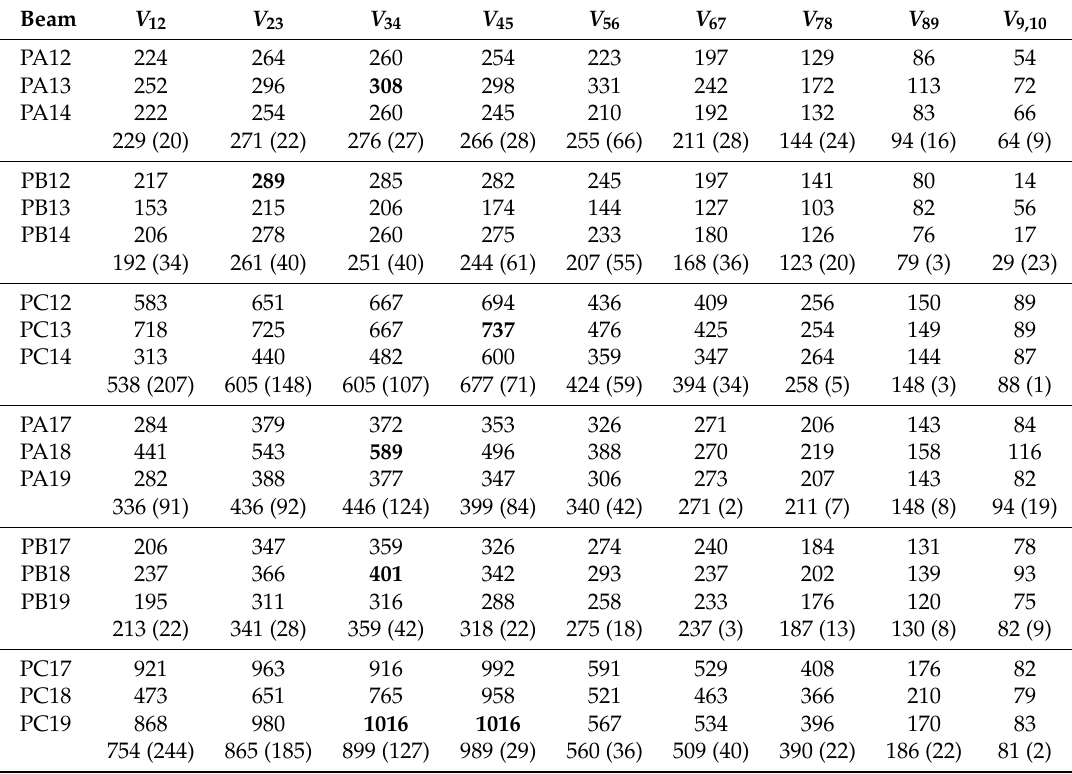
Table 9. Numerical results on the crack velocity (m/s) for the loading rate of 1.77 m/s (PX12, PX13 and PX14) and 2.66 m/s (PX17, PX18 and PX19), the mean values with the standard deviation in the parentheses are given in the fourth row of each concrete type. The maximum values in each group are marked as bold numbers.